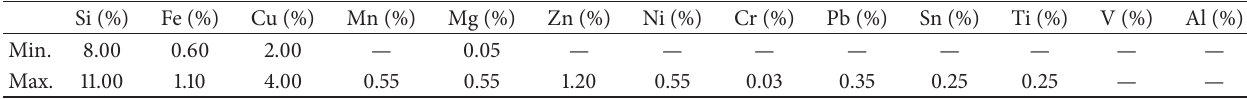
Table 3: Intervals of contents of particular elements as stated by the norm STN EN 42 4331.